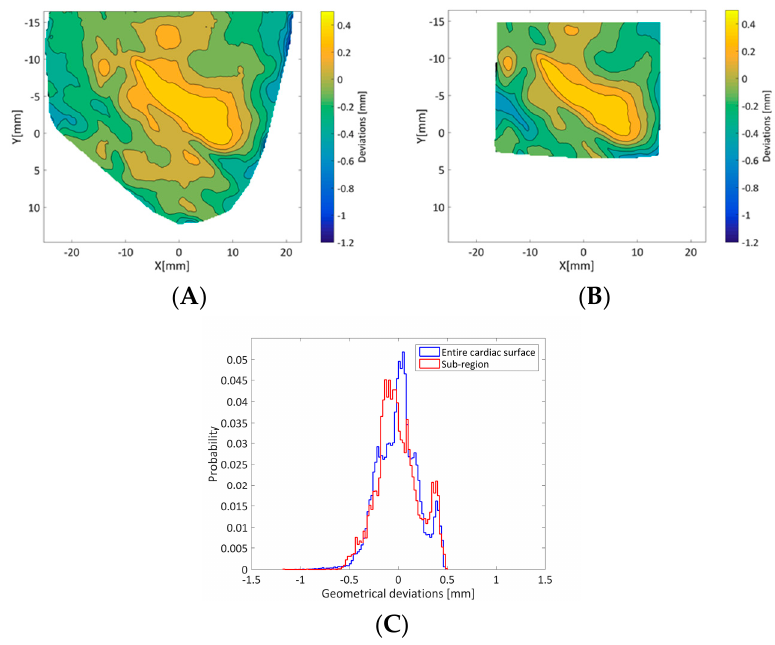
Figure 7. Contour plot of the geometric deviations in the Z direction: ( A ) between 3DsurfCTS-WS and 3Dsurf3DM-WS and ( B ) between 3DsurfCTS-WS and 3Dsurf3DM-SR. ( C ) Histogram indicating the probability distribution of the geometrical deviations between the two surfaces.